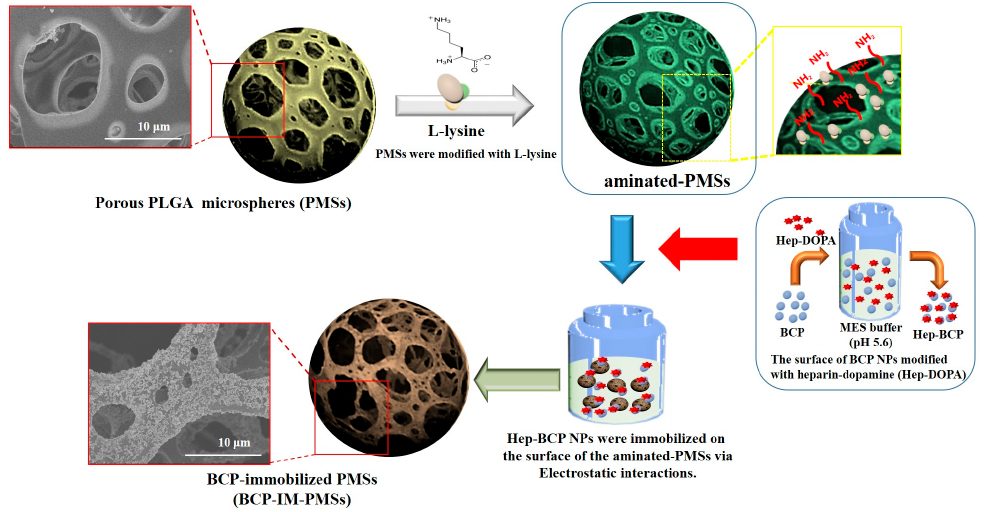
Figure 1. Schematic diagram of the fabrication of biphasic calcium phosphate (BCP)-immobilized porous microspheres (BCP-IM-PMSs). PMSs were fabricated using a fluidic device. Next, the fabricated PMSs were treated with L -lysine, yielding aminated-PMSs. BCP nanoparticles (NPs) were modified with heparin-dopamine (Hep-DOPA) to obtain Hep-BCP NPs. Finally, BCP-immobilized PMSs (BCP-IM-PMSs) were fabricated by immobilization of Hep-BCP NPs on the surface of the aminated-PMSs via electrostatic interactions.